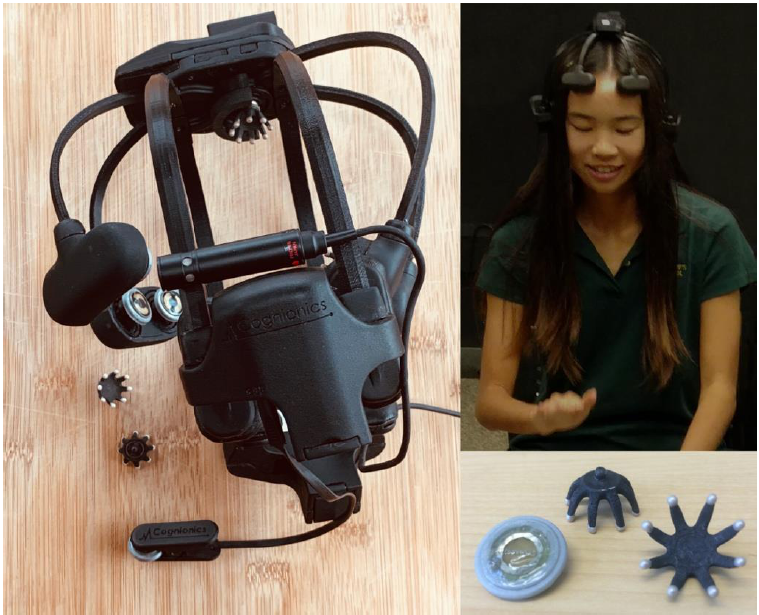
Figure 2. Left: Cognionics headset used for the present study (viewed from the left); right top: a research assistant tests the headset and drum machine; right bottom: tined and smooth electrodes for placement in hair and on the skin, respectively.